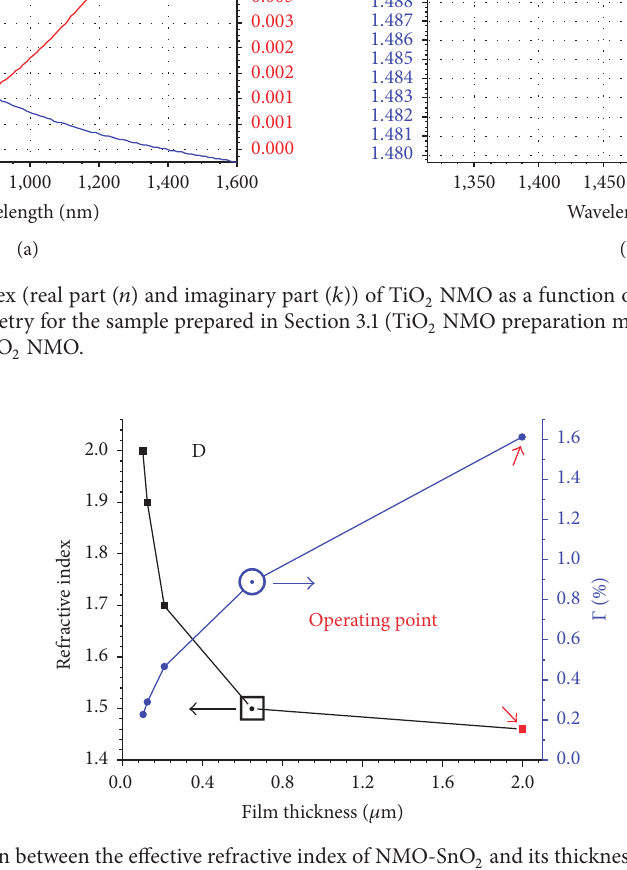
Figure 8: The relation between the effective refractive index of NMO-SnO 2 and its thickness on the optical fiber